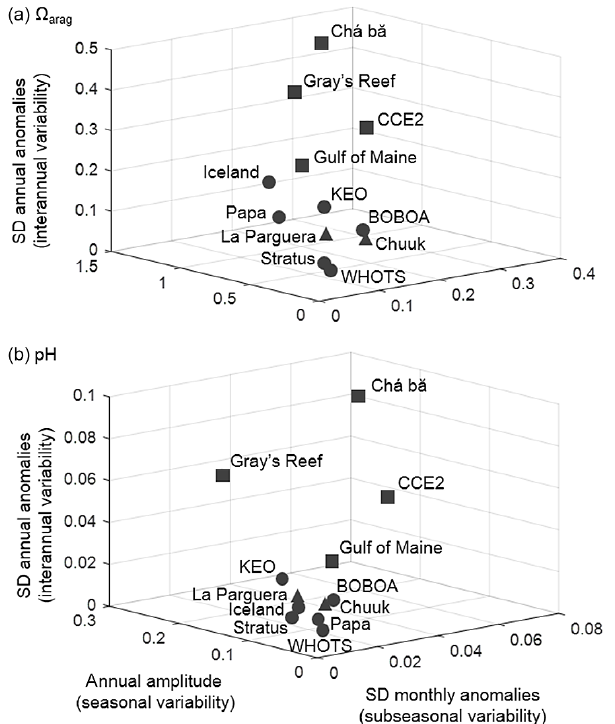
Figure 8. Relational plot of different modes of (a) (cid:127) arag and (b) pH variability for each ocean acidification mooring location. Statistics describing variability include 1SD of monthly anomalies (monthly mean – monthly observations), annual amplitude (max- imum monthly climatological mean – minimum monthly clima- tological mean), and 1SD of annual anomalies (annual mean – mean observations). Circles represent open ocean mooring loca- tions, squares denote coastal sites, and triangles denote coral reefs.